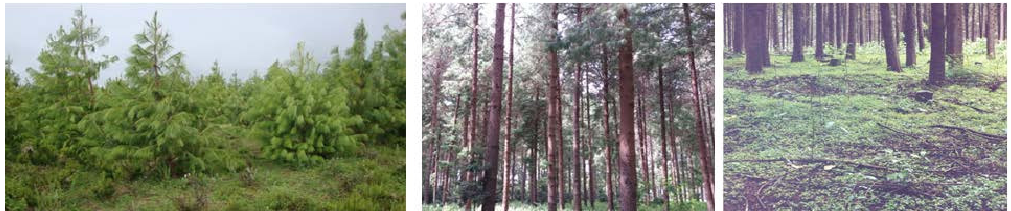
Figure 2. Plantation of Pinus patula where sporocarps collection was carried out in Wondo Genet (photo credit: Tatek Dejene).